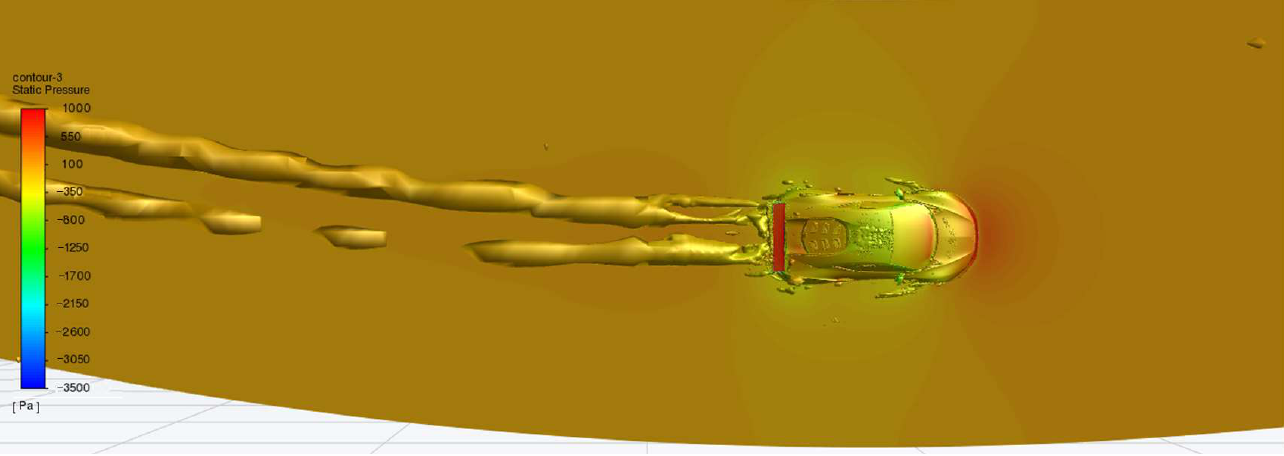
Figure 27. Pressure distributions on the car surface and the iso-surface of dimensionless parameter Q = 0.15 during cornering (R = 90 m) obtained from the RANS simulations.